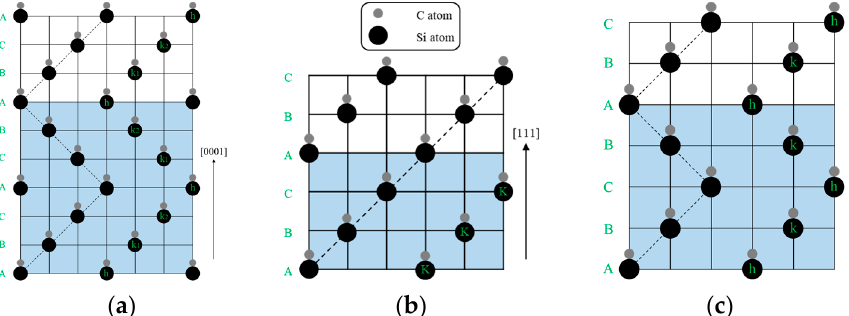
Figure 2. Three main crystalline forms of silicon carbide. ( a ) ( α )6H-SiC; ( b ) ( β )3C-SiC; ( c )